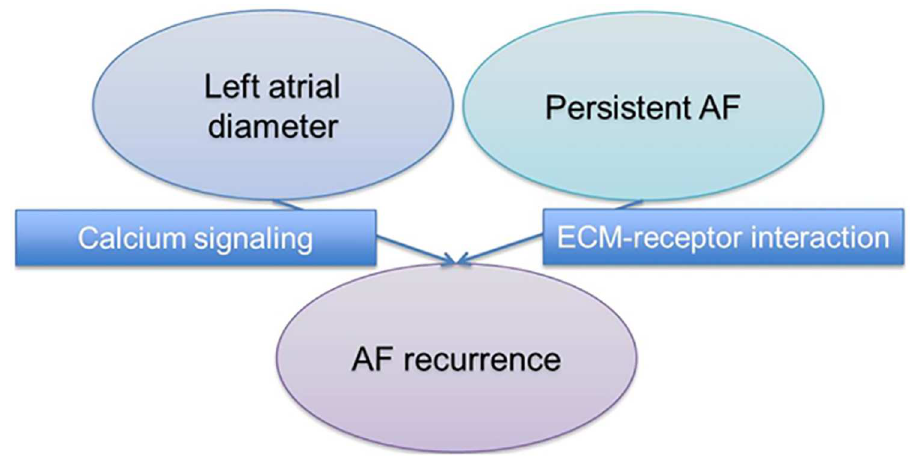
Fig 2. Clinical and genomic associations between LAD, AF type and AF recurrence. Left atrial enlargement and persistent AF are associatedwith rhythm outcome of AF catheter ablation,but whetheror not there are sharedcommon geneticpathways is unknown.In this study, we found calciumsignalingand ECM-receptor interaction pathways to be associatedwith left atrial diameter and persistent AF and, in turn, with AF